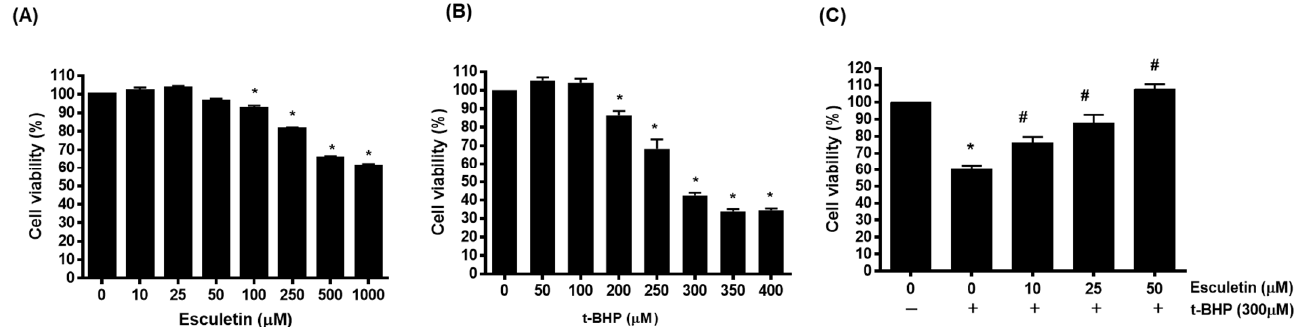
Figure 1. Effect of esculetin on t-BHP-induced HEK293 cell injury. The cell viability of HEK293 cells exposed to different concentrations of esculetin ( A ), t-BHP ( B ) and t-BHP with esculetin ( C ). In the bar graphs, the values represent means ± SD, n = 5. * p < 0.05 vs. untreated control group, # p < 0.05 vs. t-BHP-treated control group.